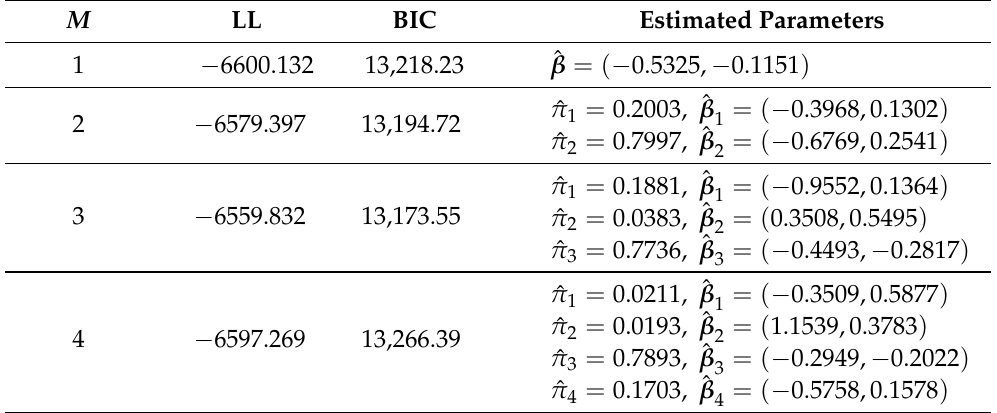
Table 7. Estimation results for migraine data with M = 1,2,3,4: the number of subgroups ( M ), the maximum log-likelihood values (LL), the BIC values (BIC), and the estimated parameters. M LL BIC Estimated